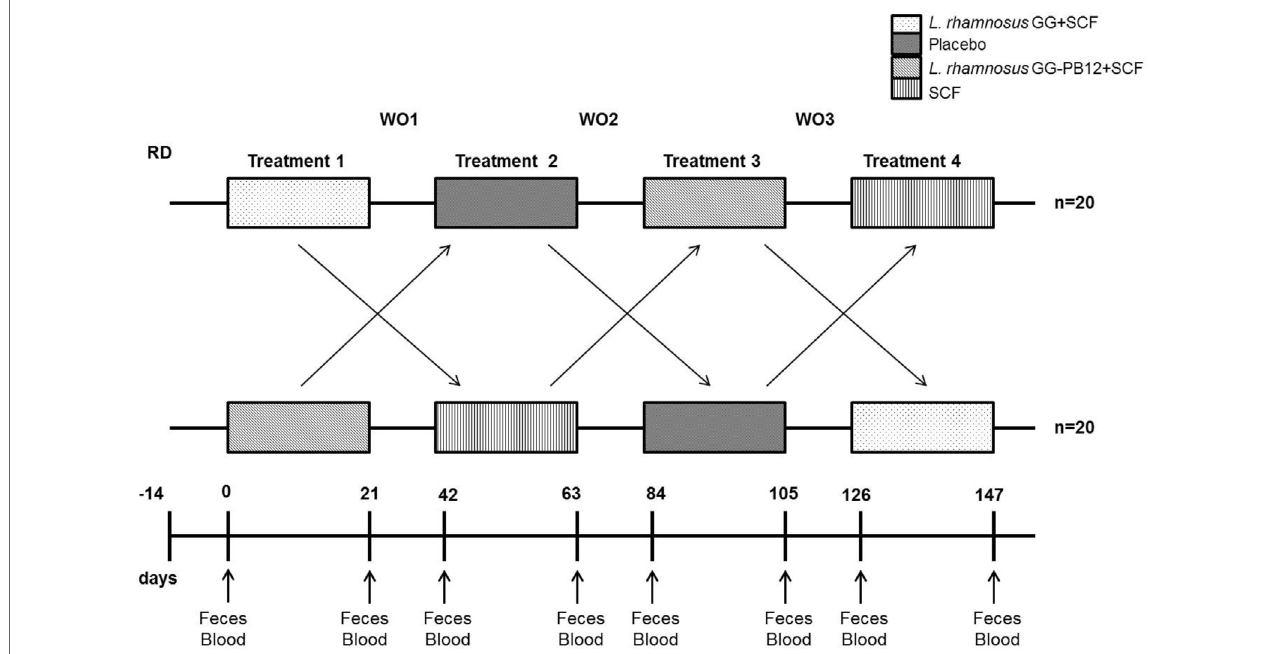
FiGUrE 2 | Saimes study design. The study was designed as a prospective, double-blind, randomized, placebo-controlled, single-centered crossover study with a 14 days run-in period prior to the beginning of the study, when volunteers were required to refrain from any probiotic or prebiotic containing food or drinks and control the fiber levels. The microbiota was analyzed from fecal samples taken prior to the intervention (time point 0) and at the end of the 3-week interventions (time points 21, 63, 105, and